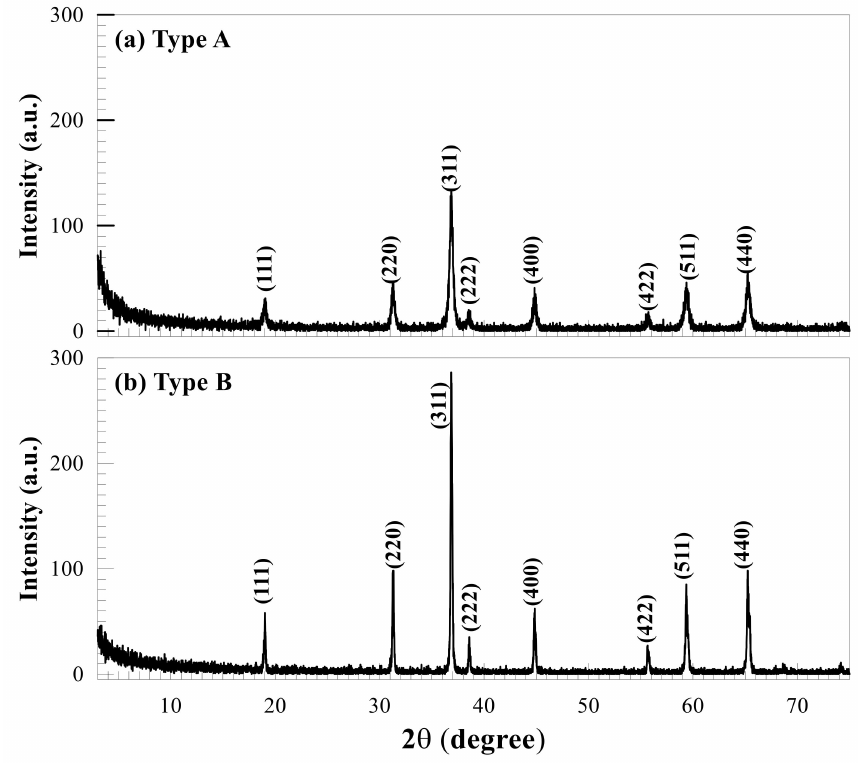
Figure 3. X-ray di ff raction patterns of the two types of Co-NPs of di ff erent sizes. ( a ) for type A Co-NPs; ( b ) for type B Co-NPs.